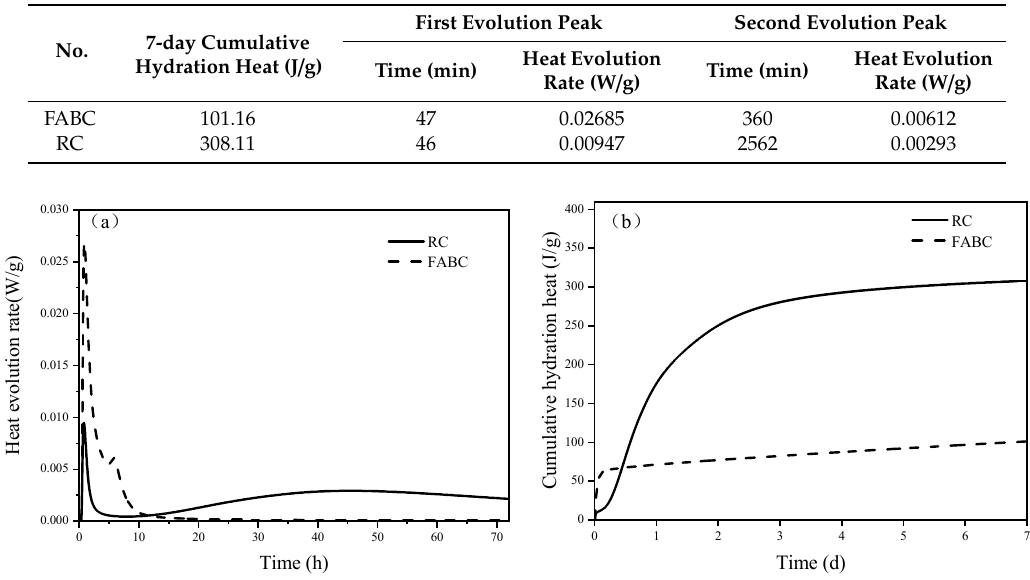
Table 3. Heat evolution characteristics of FABC and RC.